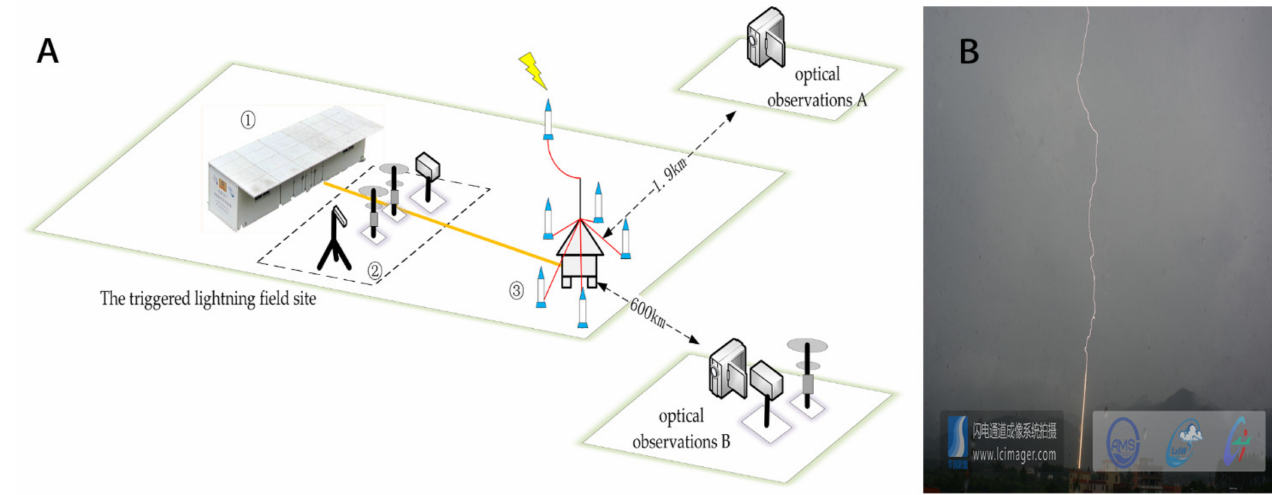
Figure 3. ( A ) Layout of the triggered lightning test site. 1 (cid:13) Control room; 2 (cid:13) region for measurement of electromagnetic signals, 3 (cid:13) artificially triggered lightning device, including six rocket launcher, lightning rods, and lightning current measurement equipment in the cabin. ( B ) A photo of a triggered lightning.